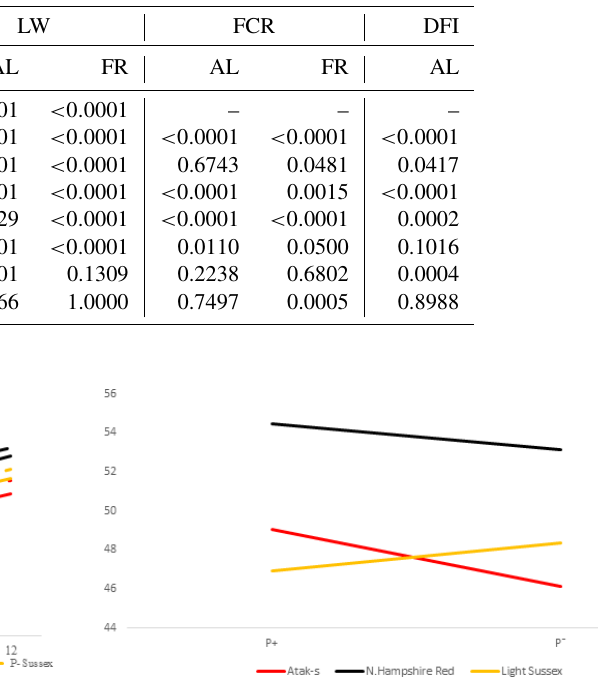
Figure 3. Trends of weekly average live weights for P + and P − groups by genotype in feed-restricted environment (grams).